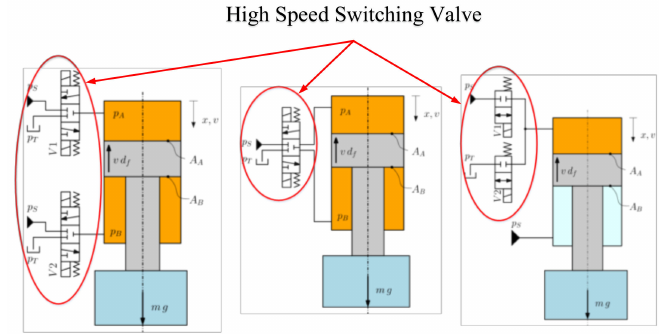
Figure 29. Position and speed control of the hydraulic